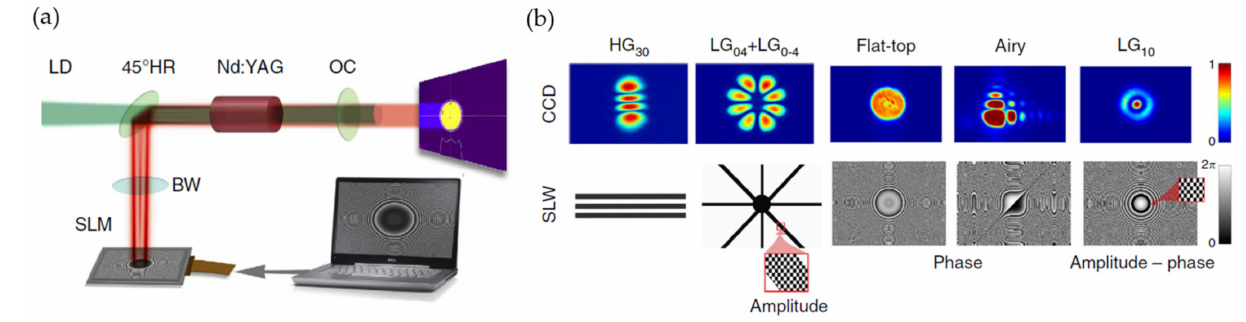
Figure 4. A digital laser for on-demand laser modes. ( a )Schematic of the laser. ( b )The greyscale images and corresponding laser field. Reprinted with permission from [119] © 2013 Macmillan Publishers